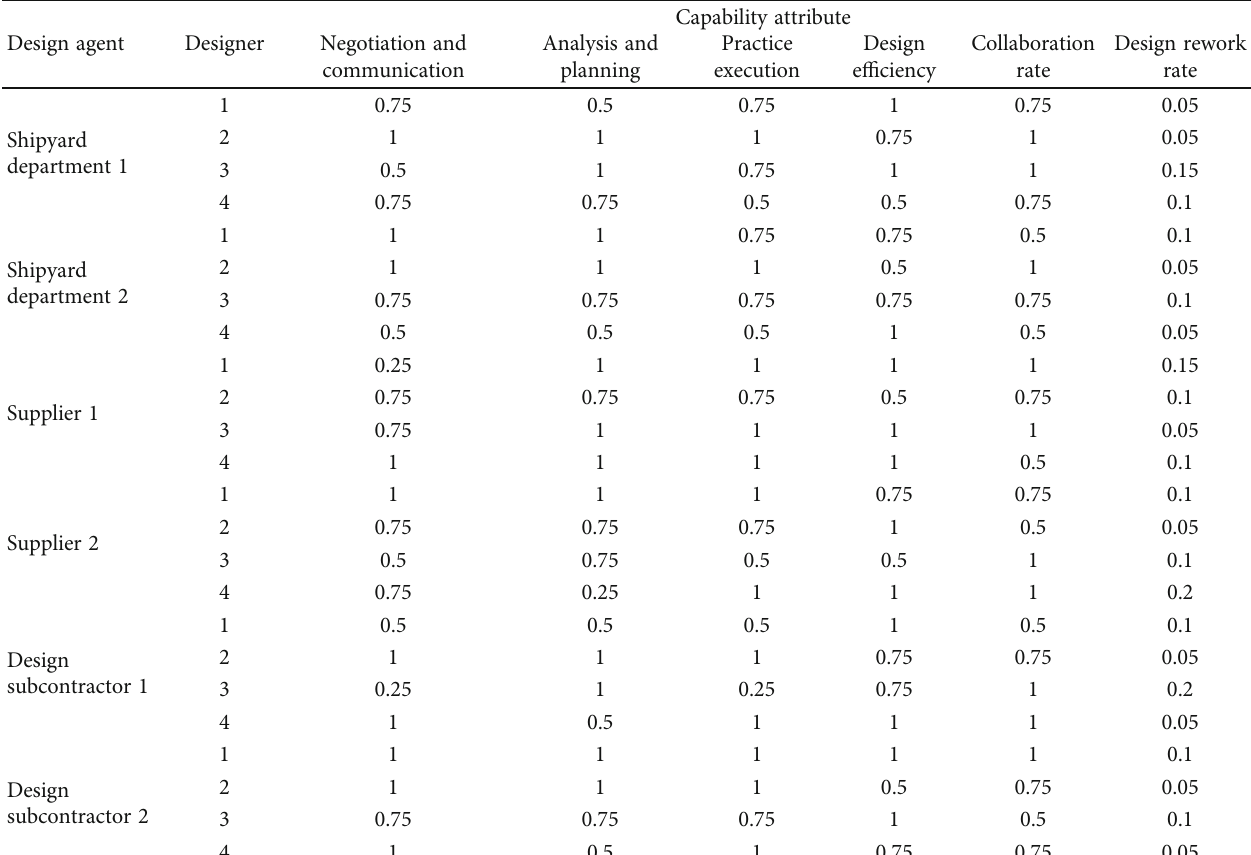
Table 11: Designer capability attribute.